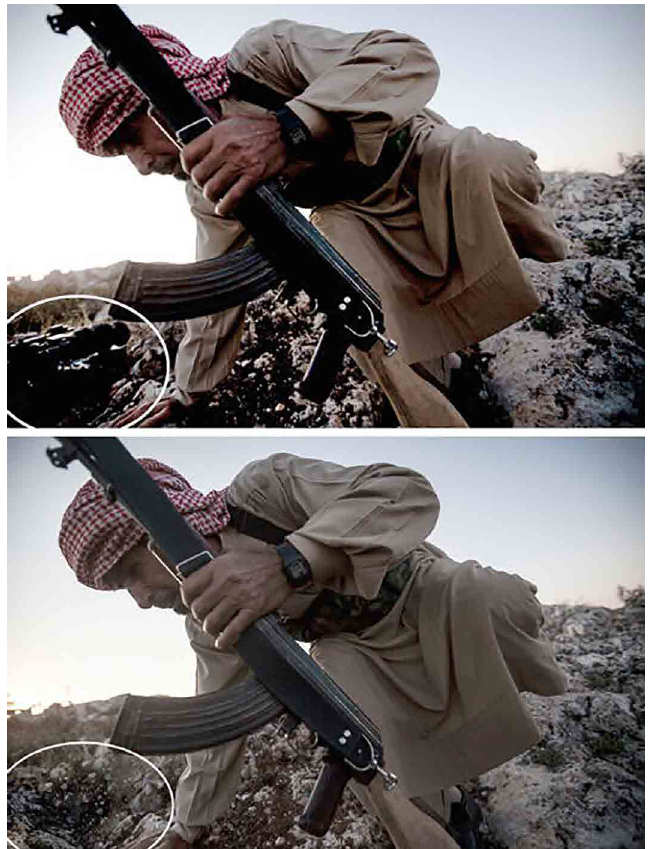
Fig. 2 Narciso Contreras, A